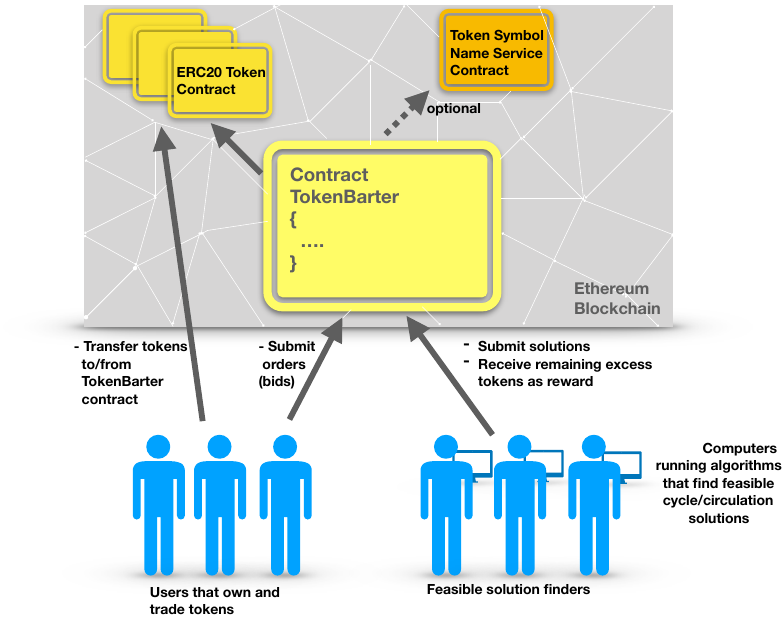
Fig. 1. Decentralized autonomous barter